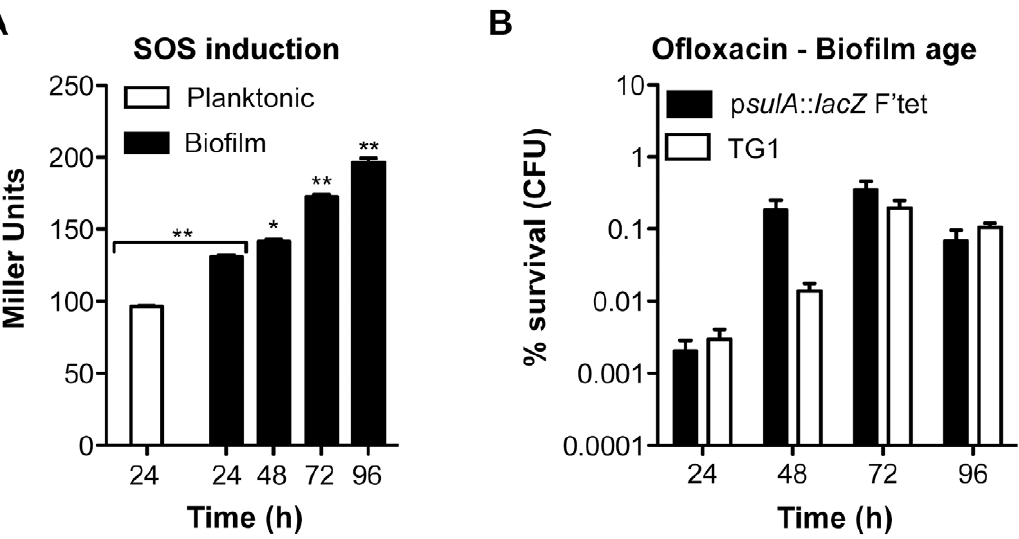
Figure 5. Induction of the SOS response and ofloxacin tolerance in aging biofilms. (A) Induction of the SOS response was monitored by b - galactosidase assay in aging biofilms and planktonic cells using an E. coli K-12 derivative carrying a p sulA :: lacZ transcriptional fusion and the biofilm promoting factor F’tet. (B) The influence of biofilm age on ofloxacin tolerance was evaluated in biofilms of the reporter strain p sulA :: lacZ F’tet (black bars) and wild-type TG1 (white bars). Briefly, all biofilms were grown for 24, 48, 72 and 96 h in M63B1 Gluc with medium renewal every 24 h. In (B) biofilms were treated for 24 h with ofloxacin (5 m g ml 2 1 , 80 6 MIC) in M63B1 Gluc , therefore in absence of starvation. Survivors were quantified by viable cell counts. Percent survival represents the tolerant population after 24 h of treatment compared to untreated biofilm prior to addition of antibiotics. Data represented are mean 6 SEM of at least three replicates. Asterisks indicate values significantly different than 24-h biofilms. Statistics were performed by the two-tailed unpaired t-test: * P # 0.001 and ** P # 0.0001.